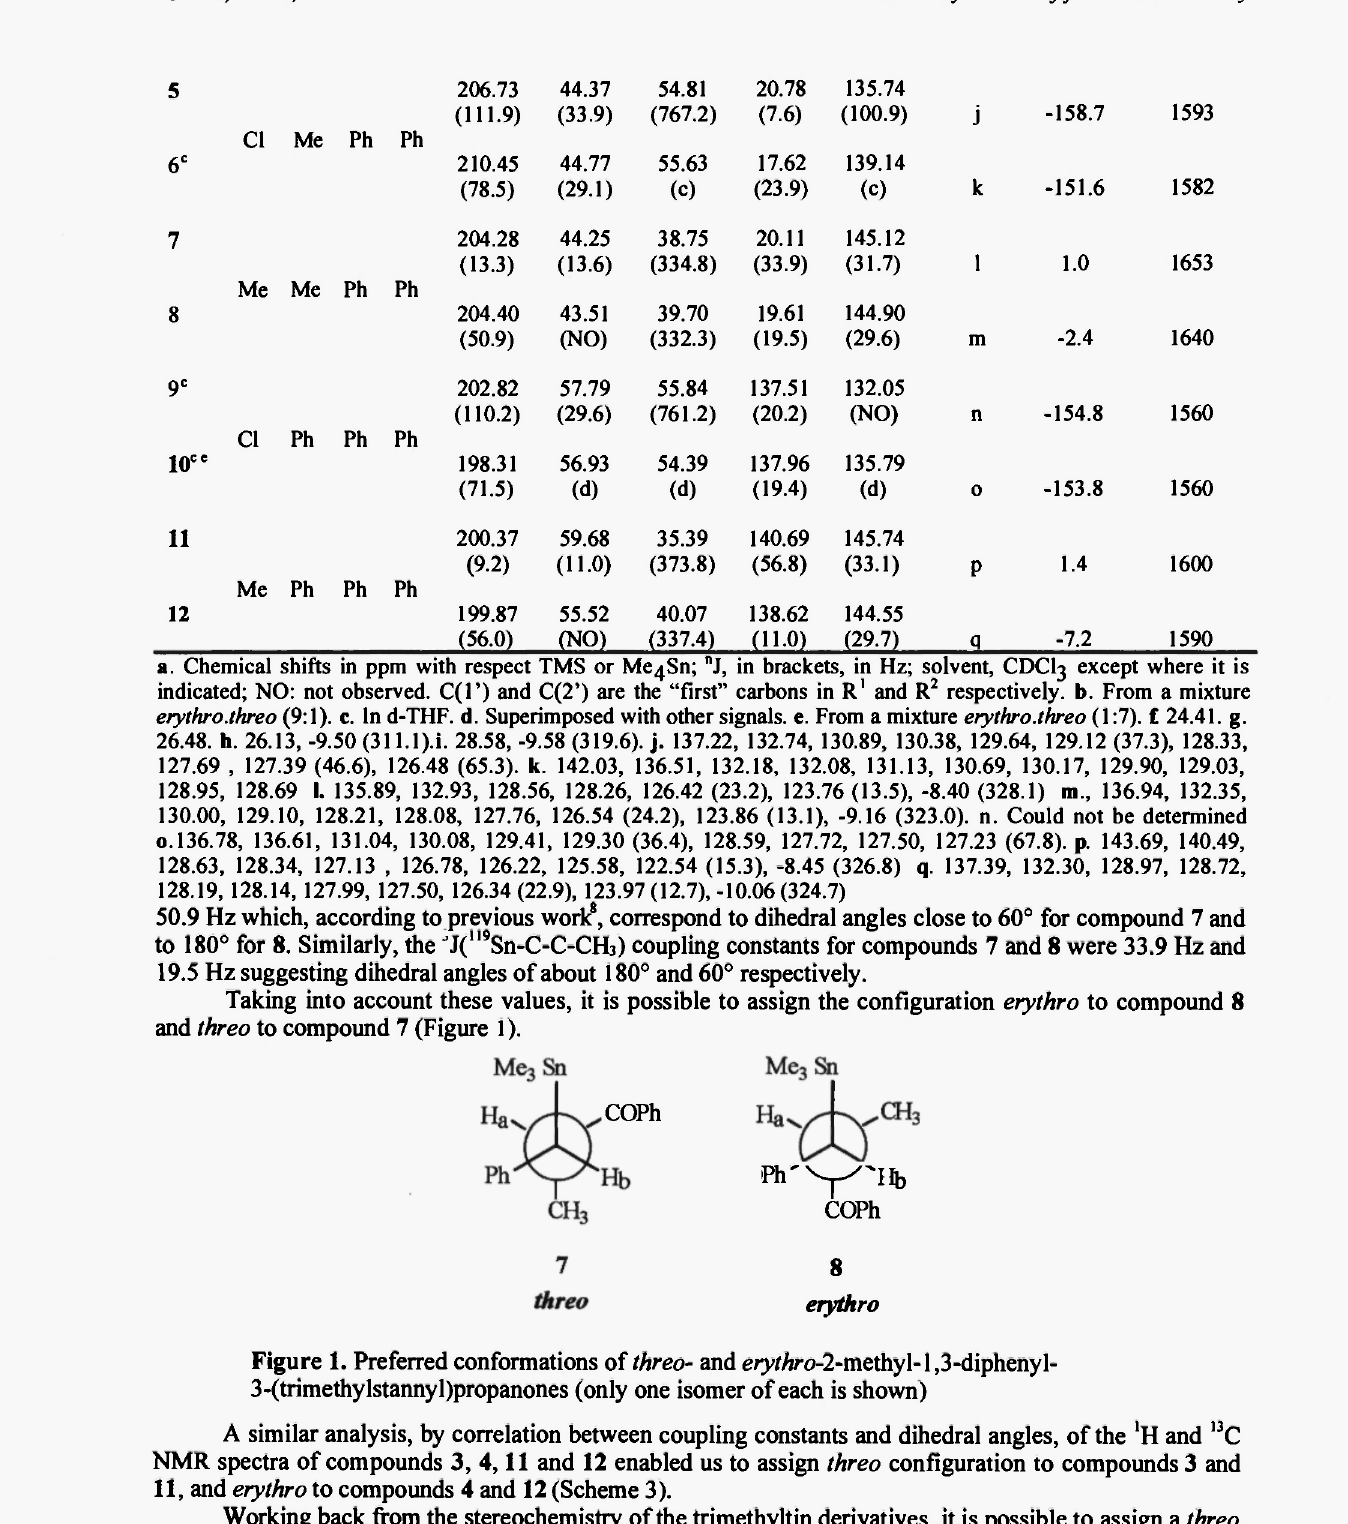
Figure 1. Preferred conformations of threo- and erythro- 2-methyl-l,3-diphenyl- 3-(trimethylstannyl)propanones (only one isomer of each is